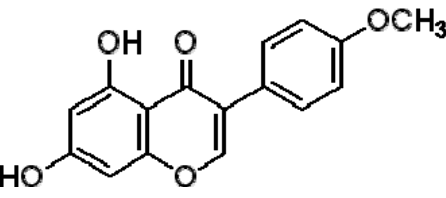
Figure 1. Chemical formula of Biochanin